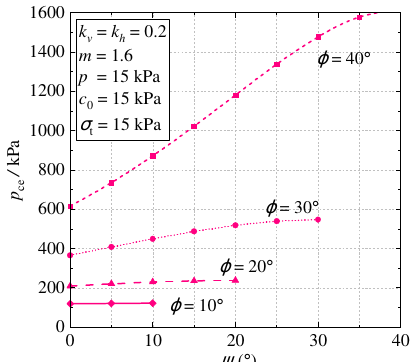
Figure 5. Influence of dilatancy coefficient on the seismic bearing capacity.